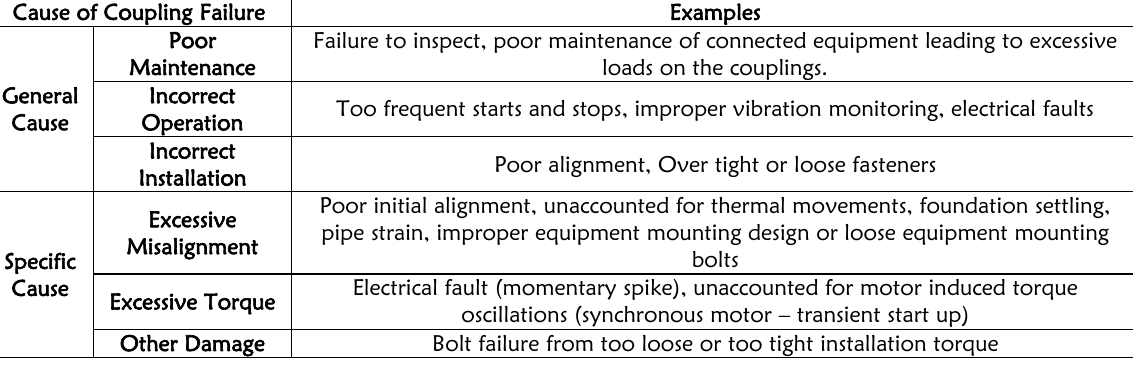
Table 2: Various types of coupling failures